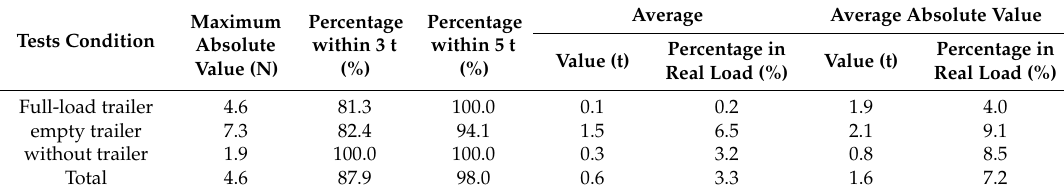
Table 5. Statistical analysis of the mass error.